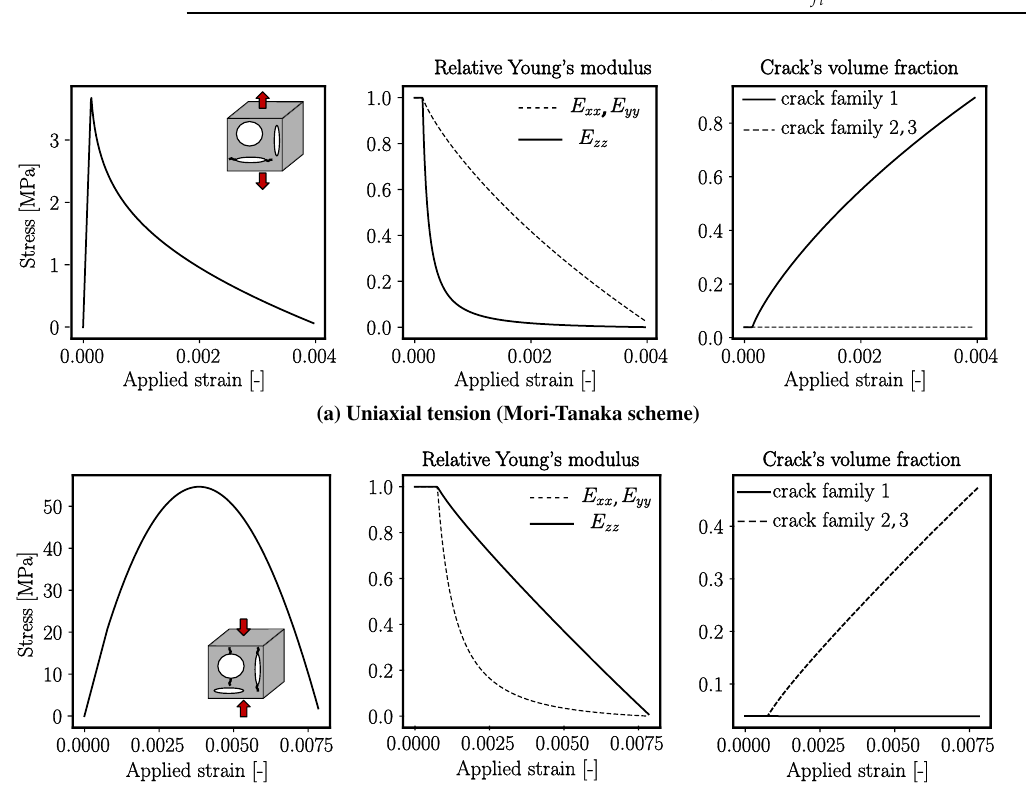
Figure 5. (Left) stress–strain relation of mortar subjected to uniaxial tension (top) and uniaxial compression (bottom). (Center) stiffness evolution due to the propagation of microcracks. (Right) growth of the volume fraction of three microcrack families. Microcrack propagation is modelled as the increase in microcrack radius according to the Griffith